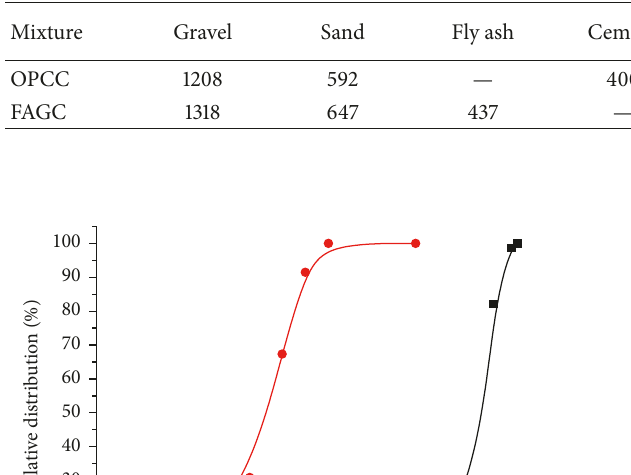
Table 3: The concrete mixture ratio designs (kg/m 3 ).